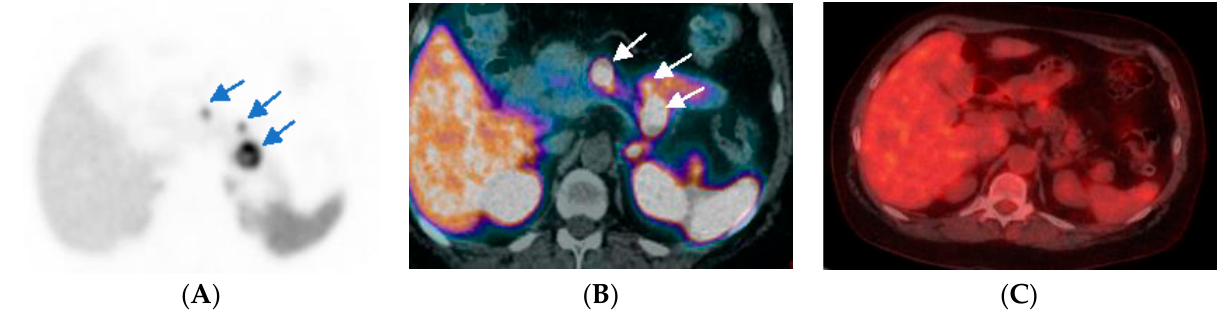
Figure 2. A patient with pathological proven pancreatic NENs (Ki-67 of 7%). 68 Ga-DOTA-NOC PET image (( A ), arrow) reveals 3 foci increased radiotracer uptake at the pancreas and also seen in axial 68 Ga-DOTA-NOC PET/CT image (( B ), arrow). However, the axial 18 F-FDG PET/CT image ( C ) shows no abnormal FDG uptake in the pancreas at the same level.